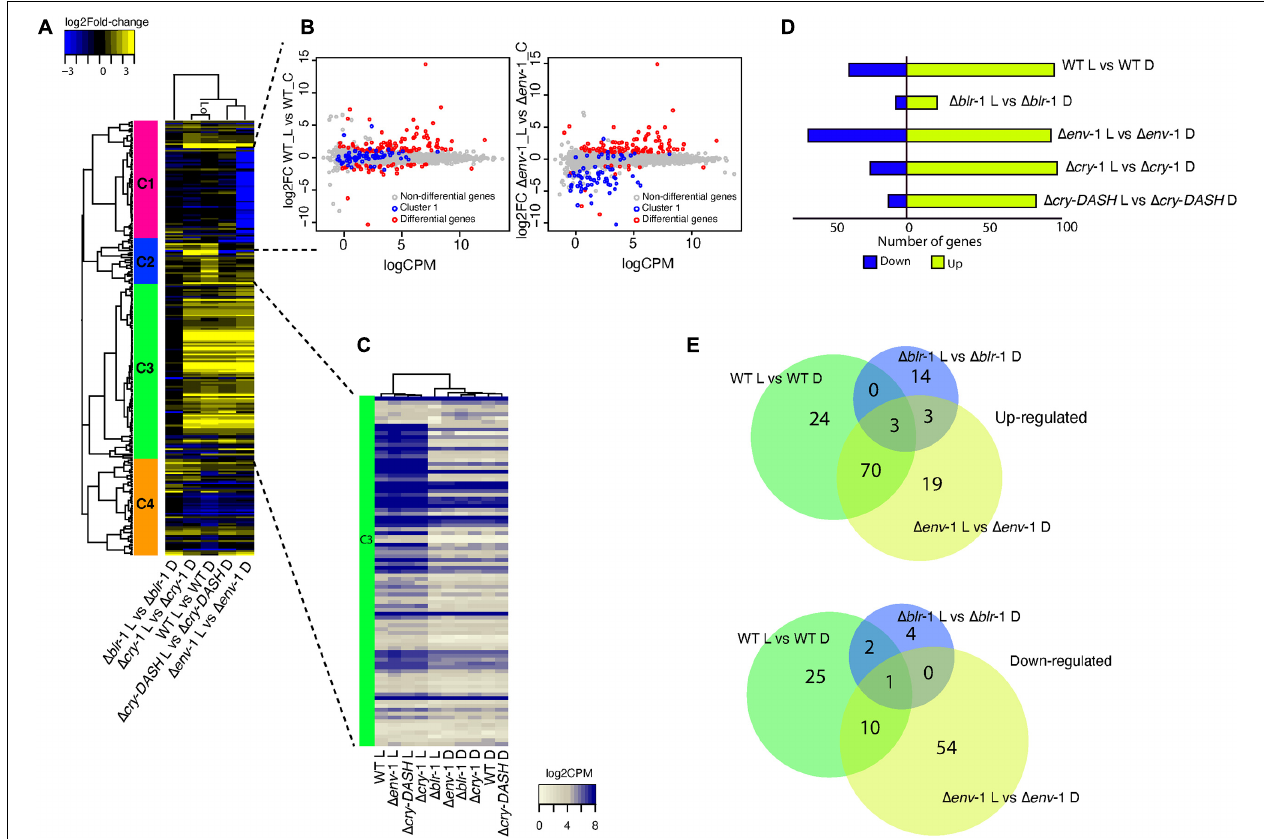
FIGURE 2 | Transcriptional profile of the WT strain and the mutants (cid:49) blr- 1, (cid:49) cry- 1, (cid:49) cry-DASH and (cid:49) env- 1 in response to a 200 µ mol · m − 2 · s − 1 pulse of blue light. (A) Heatmap of genes responsive to blue light. Colored bars with roman numerals on the left side of the heatmap indicate gene clusters differentially expressed in the WT and photoreceptor mutants. The scale bar at the top left of the heatmap indicates the gene expression intensity and the lines that support the groups formed in the heatmap are the dendrogram. (B) Smear plot generated from edgeR showing the log2 fold change (FC) against the average log count per million (CPM) of genes that respond to blue light in WT strain and (cid:49) env -1 mutant. (C) Heatmap of log count per million (CPM) values for genes exposed to blue light and kept in dark from cluster three. (D) Comparison of the expression profile of the genes differentially expressed between each strain. A Fold-Change filter of ± 1 and a FDR ≤ 0.05 was used. Strains growing in darkness were used as a control. (E) Venn diagrams showing the number of up- and down-regulated genes shared by the WT strain and the (cid:49) blr- 1 and (cid:49) env -1 mutants or that are unique for each